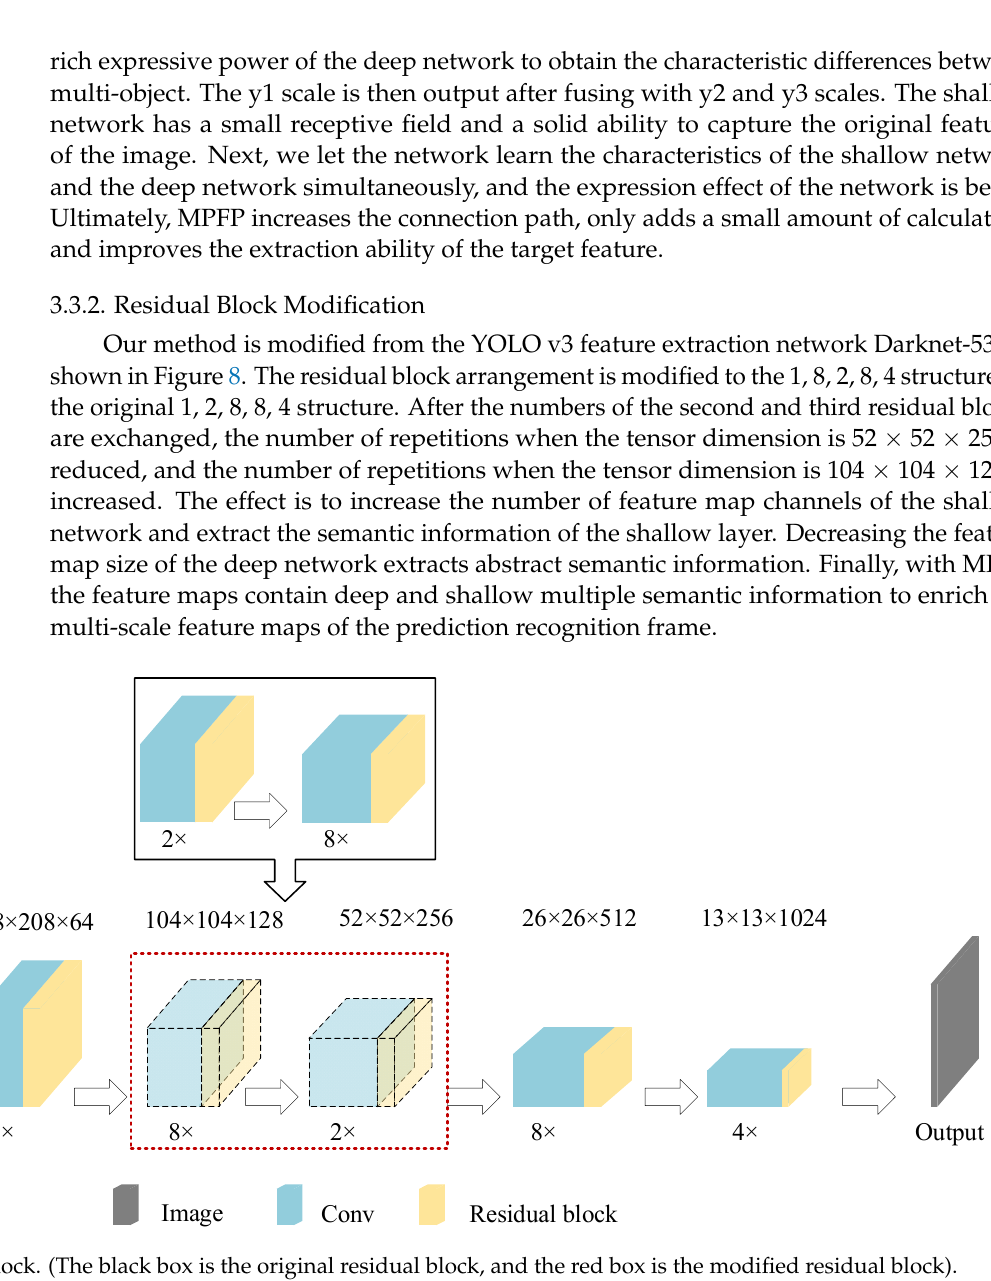
Figure 9. Priori box. 3.5. Implementation Details The network is trained on Google COLAB with the deep learning framework Pytorch 1.8.0, using the VOC2007 dataset, with 300 iterations. Freezing training can speed up the training and prevent the weights from being destroyed in the early stage of training, so the first 50 iterations of freezing training are used. The Learning Rate (LR) of the first 50 iterations is 1 × 10 − 3 , and the batch size 8, the learning rate of the 51st to 300th iterations is 1 × 10 − 4 , and the batch size 4. 3.6. Evaluation Rules At present, there are some differences in the performance of SAR imaging system, and there are some differences in the imaging effect. The size of the target in the human